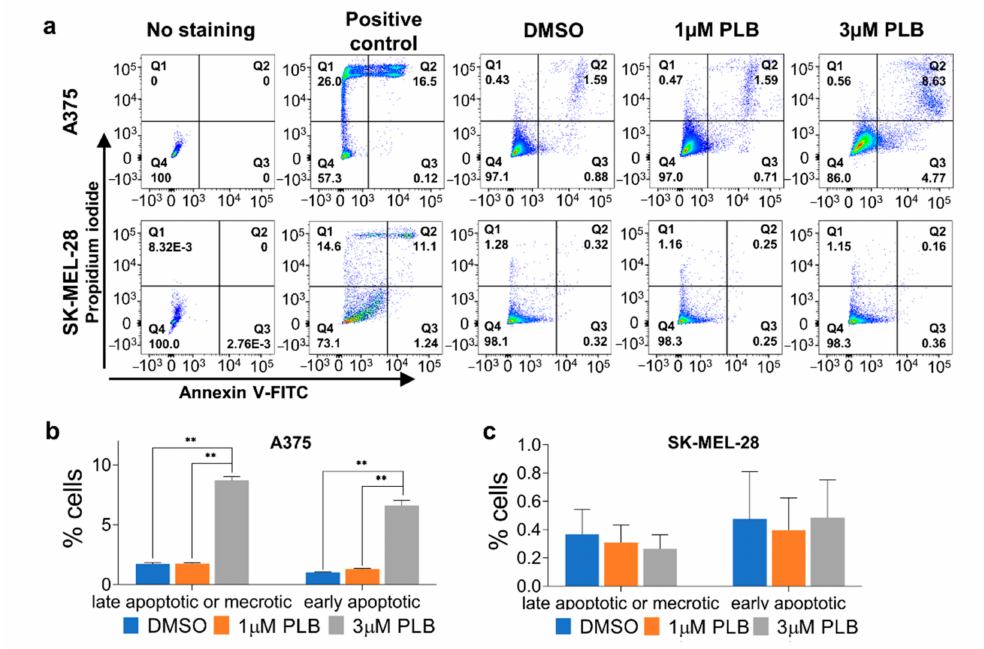
Figure 4. Differential effects of PLB on inducing A375 and SK-MEL-28 apoptosis. A375 and SK- MEL-28 cells pretreated with DMSO and 1 and 3 µ M PLB were stained with Annexin V-FITC and PI. Cells heated at 55 ◦ C for 16 min were the positive controls. ( a ) Cells with fluorescence were detected by flow cytometry. ( b ) The percentage of late apoptotic or necrotic and early apoptotic A375 cells in DMSO and 1 and 3 µ M PLB groups. ( c ) The percentage of late apoptotic or necrotic and early apoptotic SK-MEL-28 cells in DMSO and 1 and 3 µ M PLB groups. Results are expressed as mean ± SD ( n = 3). ** p < 0.01. PI, propidium